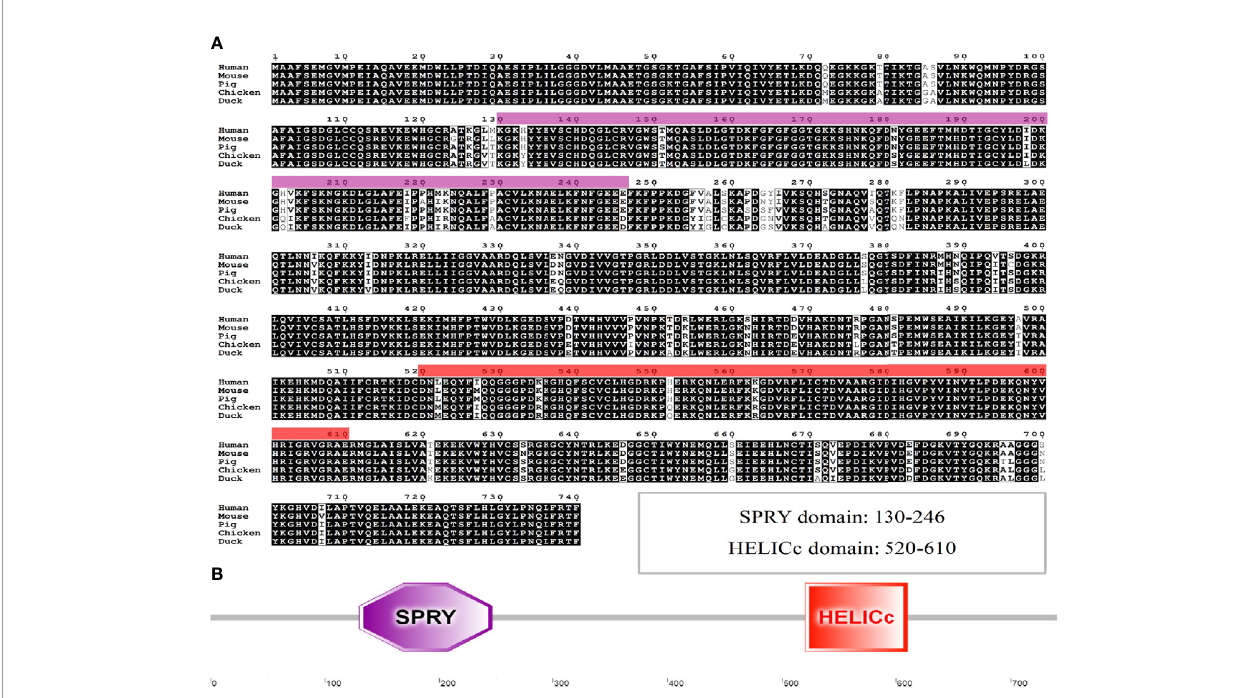
FIGURE 1 | (A) Alignment of the amino acid sequence of chDDX1 with chDDX1 proteins from humans (NP_004930.1), mice (NP_598801.1), pigs (ANR02618.1) and ducks (XP_027311055.1). The amino acid sequences of different animals were aligned using Clustal W and edited with ESPript 3.0. The black shading indicates amino acid identity, and the gray shading indicates similarity (50% threshold). (B) Protein domains of chDDX1 predicted by